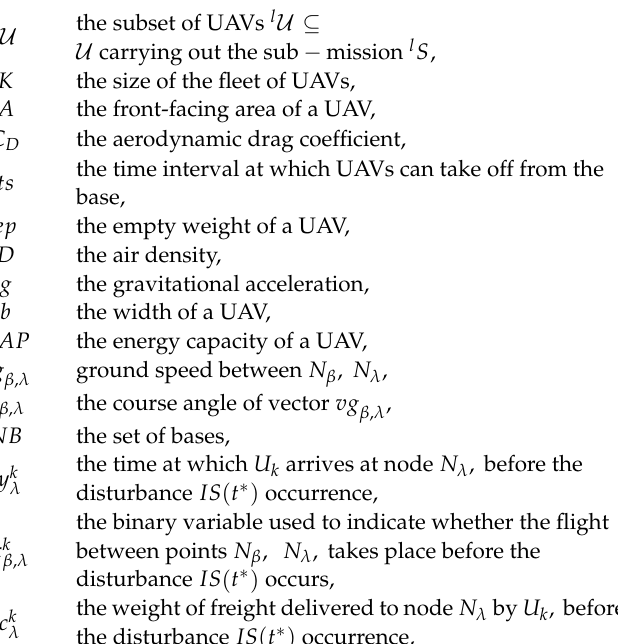
algorithm (implemented in the IBM ILOG environment) generates the end-to-end